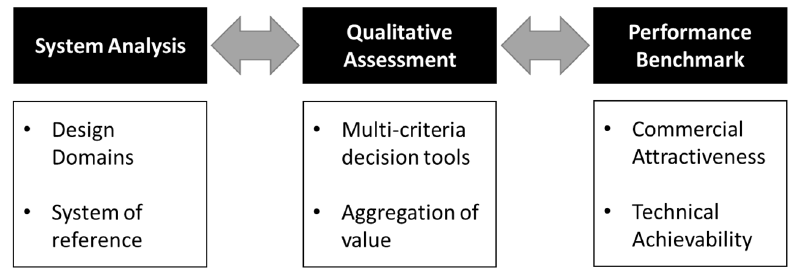
Figure 1. Proposed assessment approach.